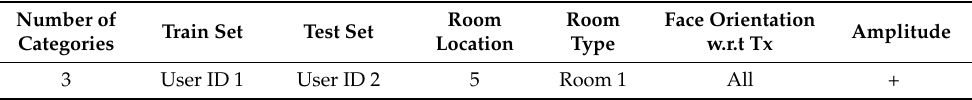
Table 1. Part of Widar3.0 dataset (described in Section 5.1) for pre-processing pipeline experiments. Number of